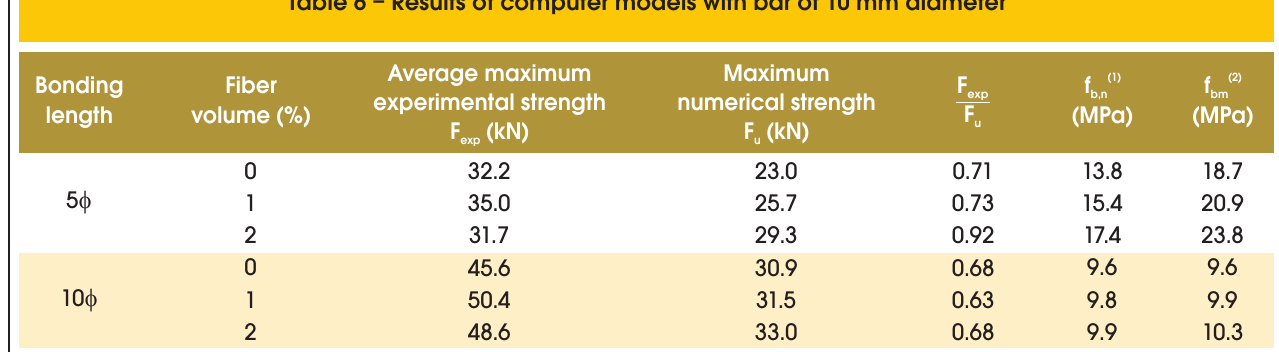
Table 6 – Results of computer models with bar of 10 mm